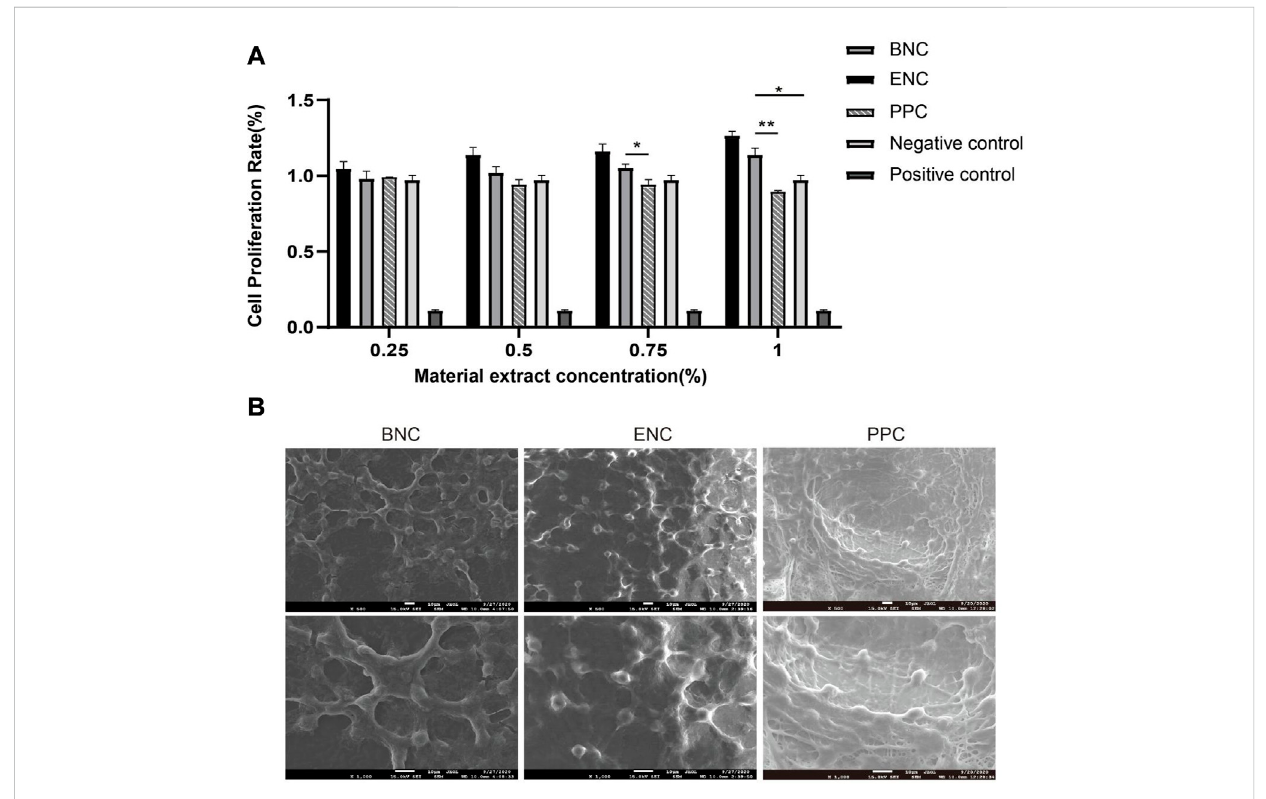
FIGURE 5 Comparison of CCK-8 assay and biocompatibility of BNC, ENC, and PPC. (A) The trend of cell relative proliferation rates of BNC, ENC, and PPC at differentconcentrations was observed on the third day. (B) SEM imagesof SCs adhesion on the surface of BNC, ENC, and PPC. Data are expressed as